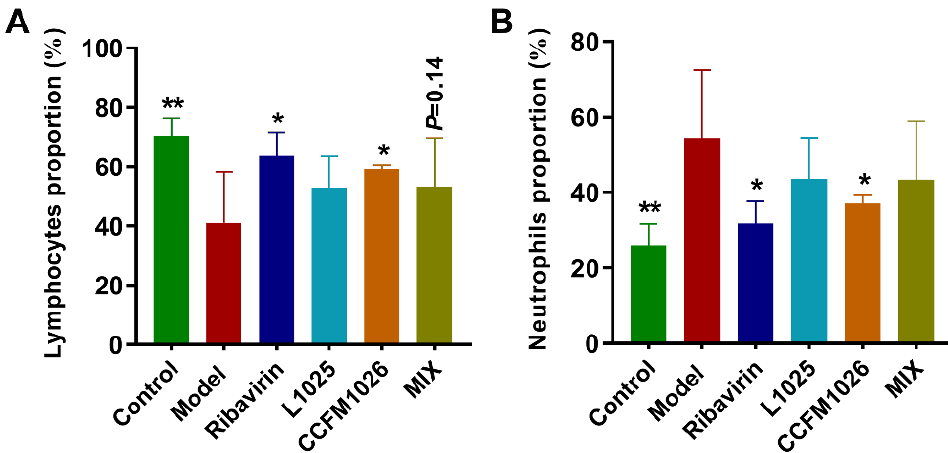
Figure 4. Alteration in systemic immune responses. ( A ) The proportion of lymphocytes. ( B ) The proportion of neutrophils. The statistical difference was evaluated using one-way ANOVA and post hoc Fisher’s least significant difference (LSD) tests (*, ** vs. the model group).